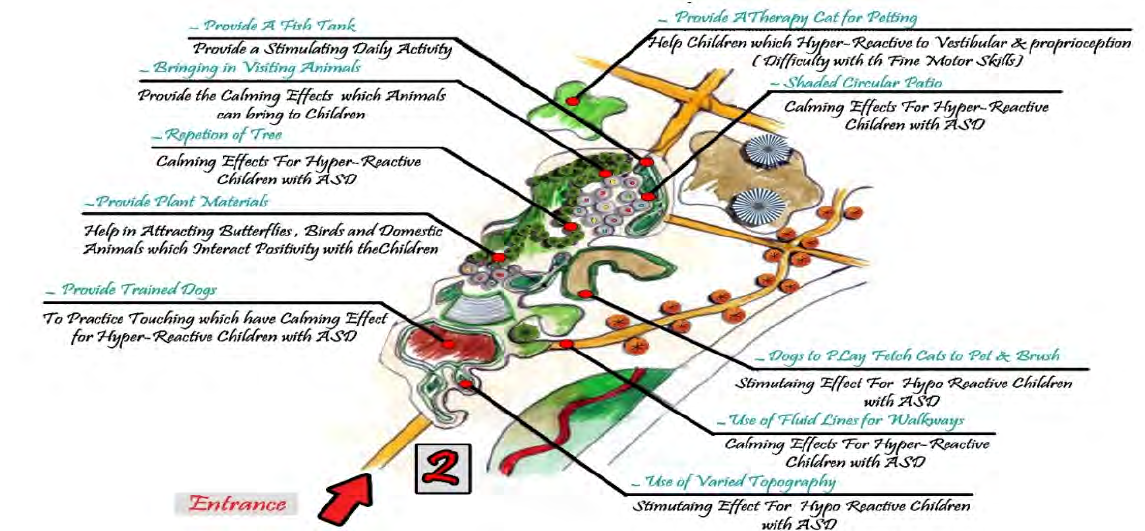
Figure 9. Shows the design consideration for the “Become the Animal” zone